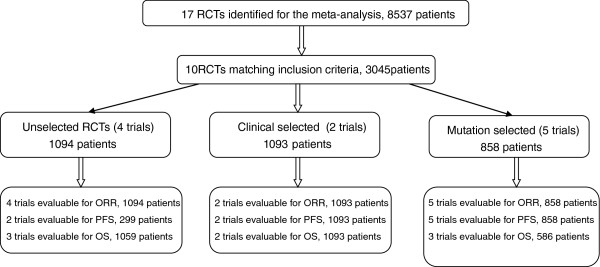
Outline of the search flow diagram.